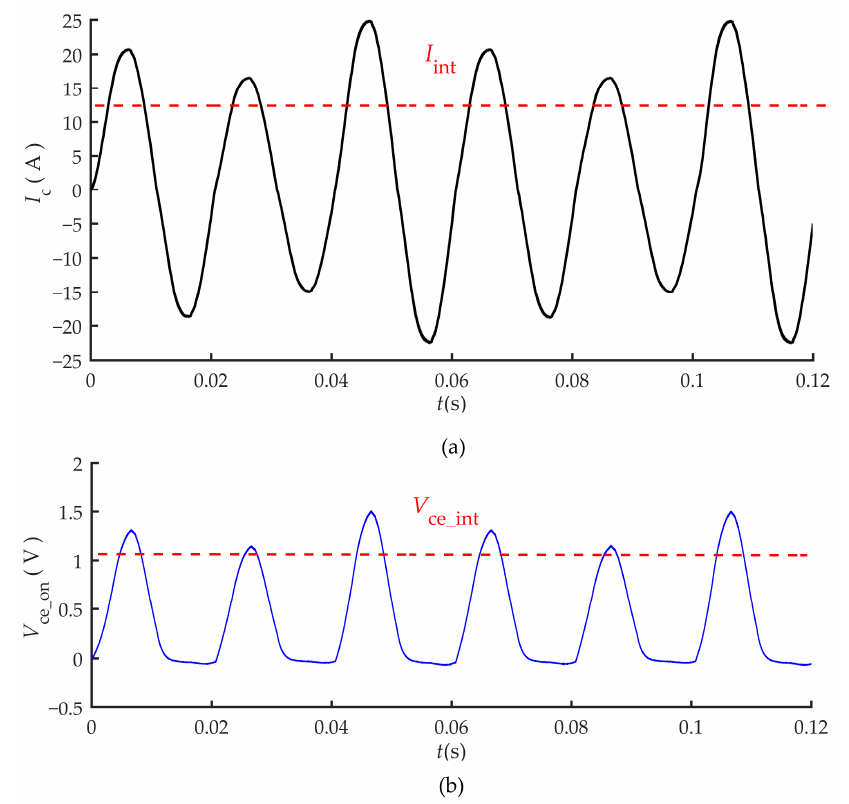
8 of 14 Table 2. Experimental platform parameter settings. Parameters